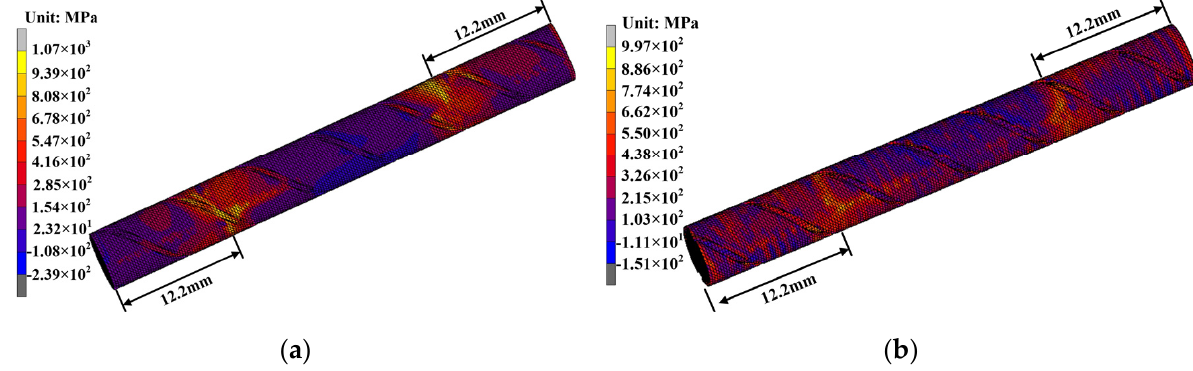
Figure 10. Von Mises stress distribution of the bolt (when the load reaches the maximum): ( a ) con- nected by merging nodes; ( b ) connected by gluing contact.